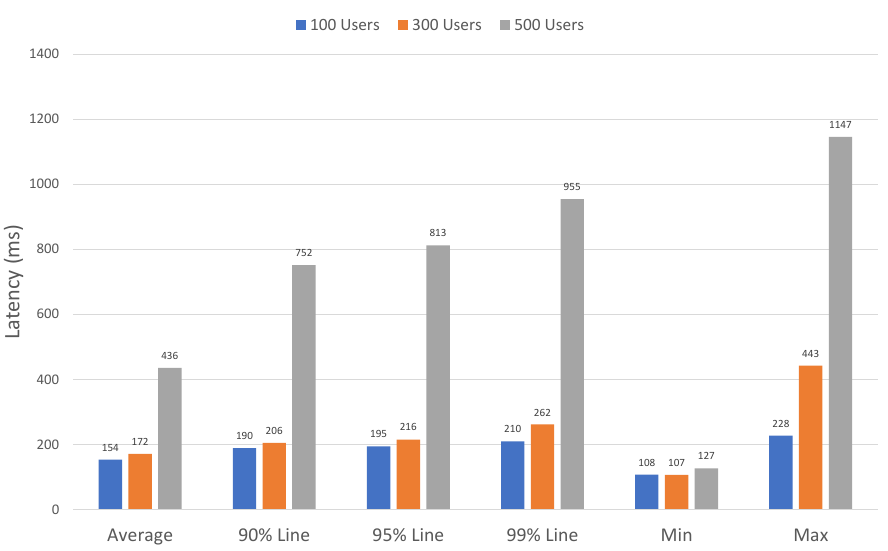
Figure 28. Latency in query transaction (Get